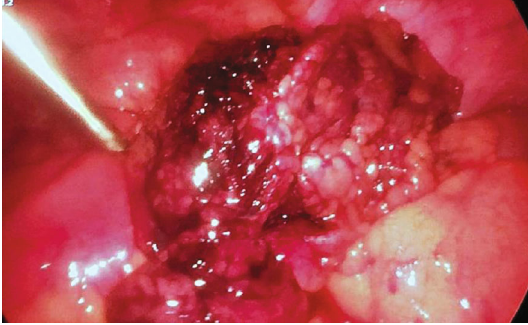
Figure 2: Omental mass - laparoscopic